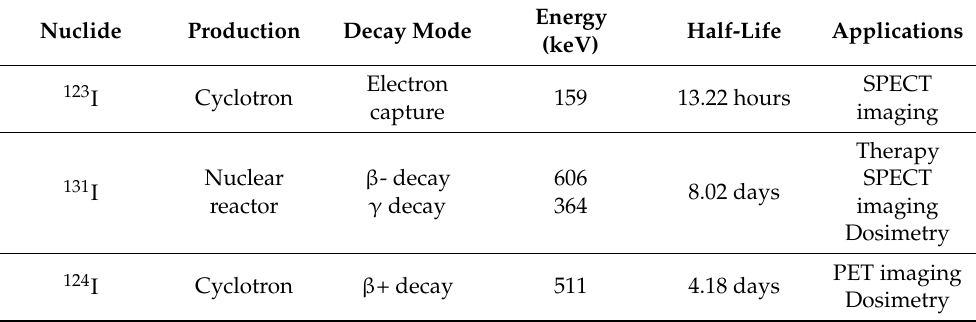
Table 1. RAI isotopes available for diagnosis and treatment of